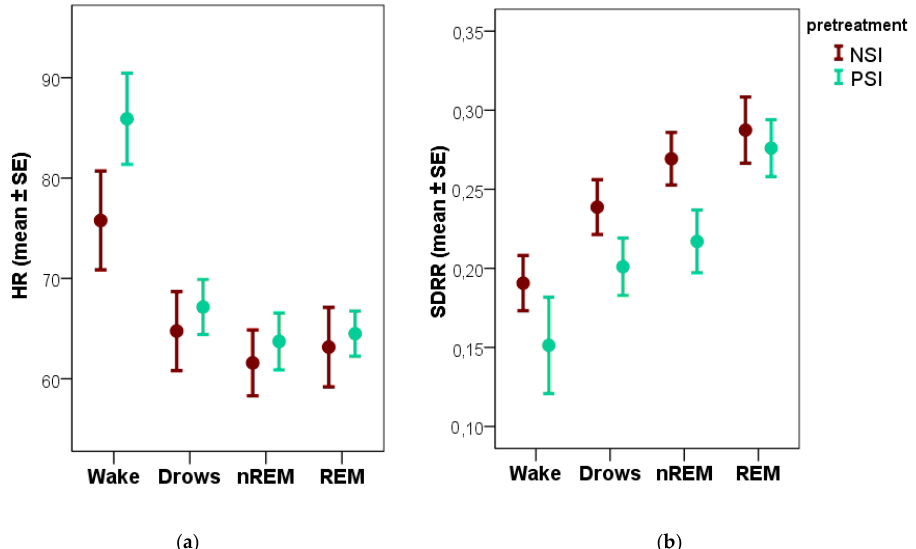
Figure 3. Differences in heart rate ( a ) and SDRR, a heart rate variability measure ( b ) during wakefulness and the sleep stages following positive versus negative social interaction. NSI: negative social interaction; PSI: positive social interaction.